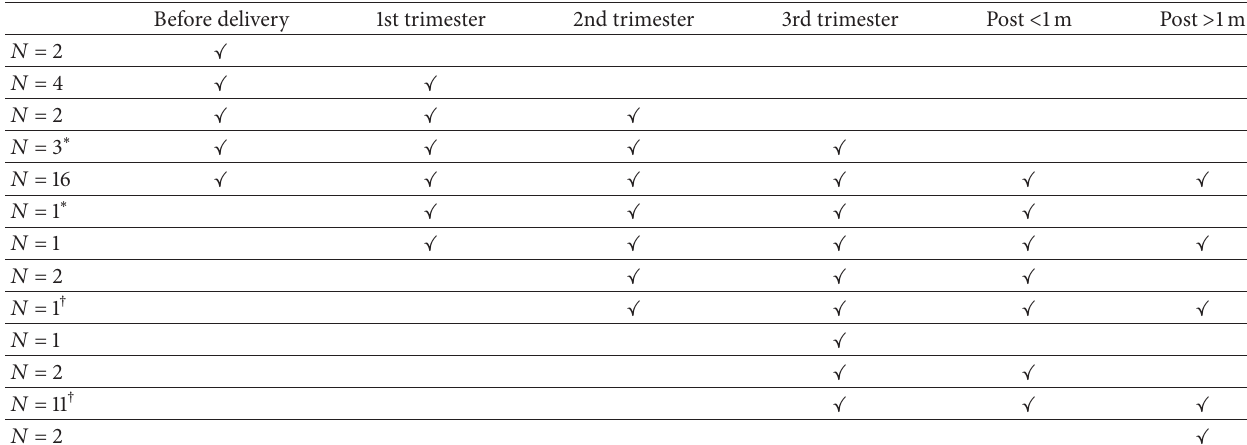
Table 4: Antiviral treatment patterns among 48 pregnant women with chronic hepatitis B virus infection with a delivery date in 2011. Before delivery